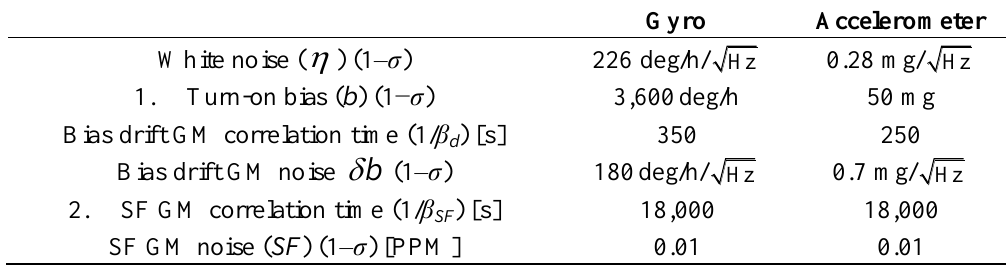
Table 1. Simulated MEMS inertial sensor